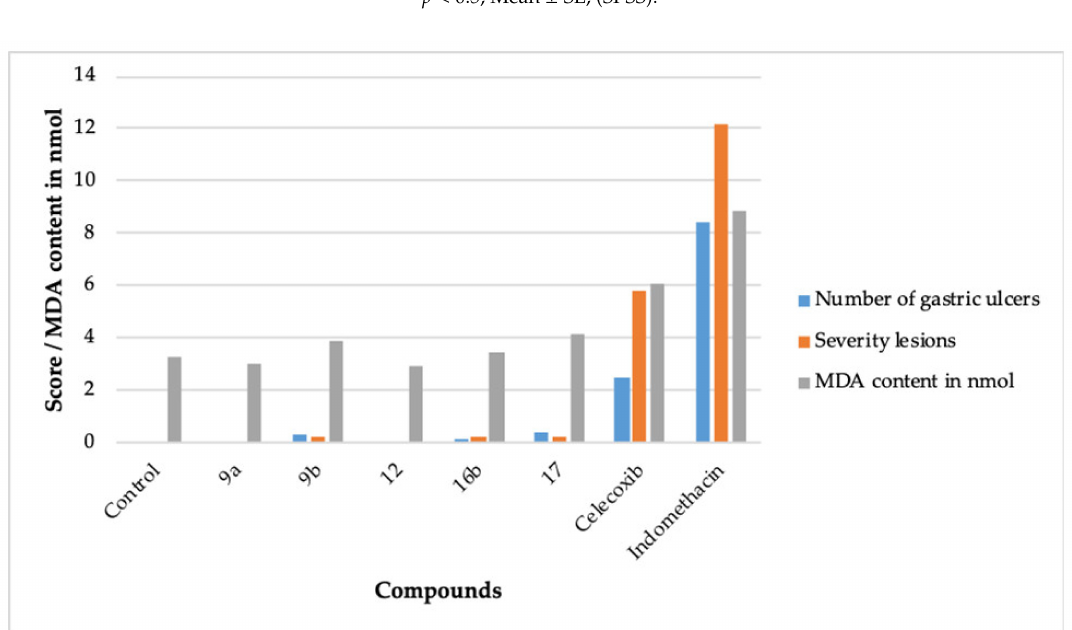
Figure 3. The ulcerogenic and lipid peroxidation activity e ff ect of 9a , 9b , 11 , 15b , 17 , celecoxib, and